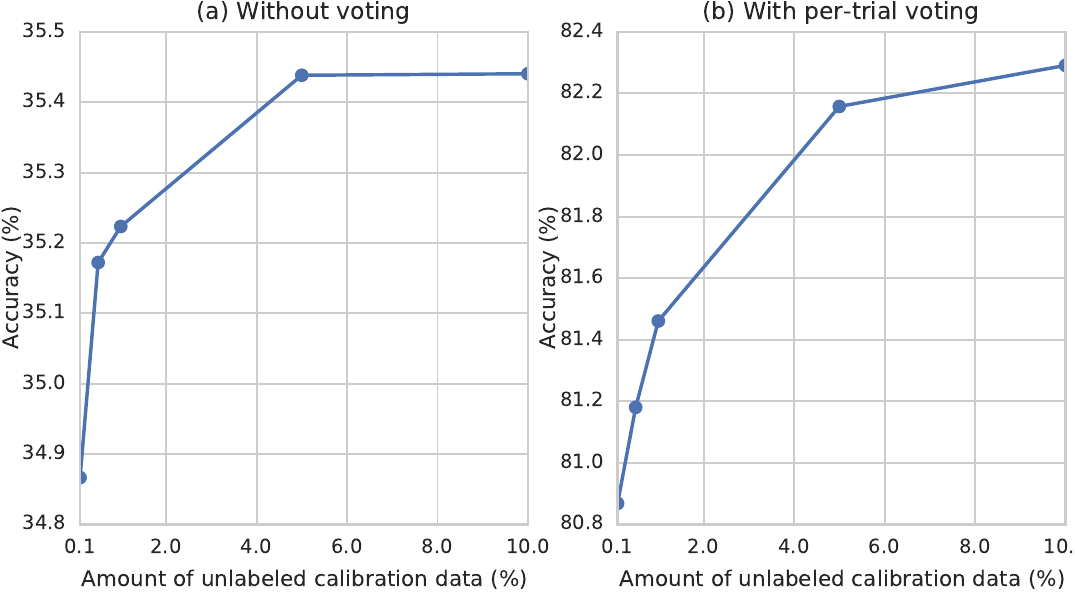
Figure 7. Recognition accuracies with different amounts of unlabeled calibration data for inter-session evaluation of